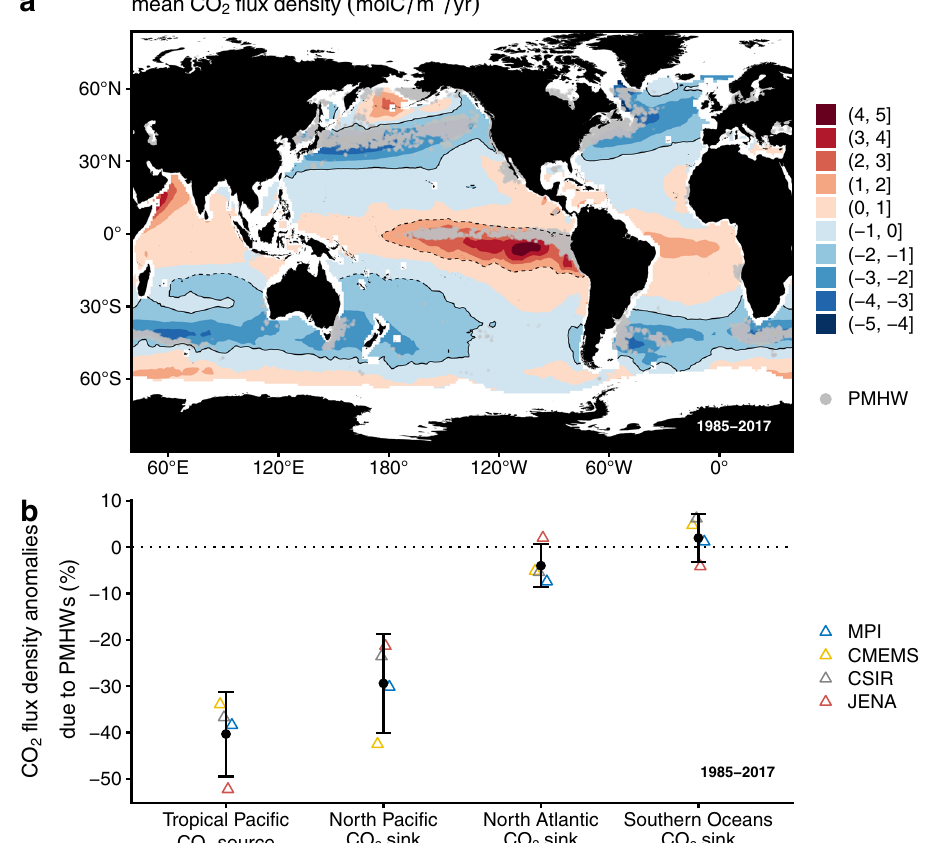
Fig. 1 | Interplay of PMHWs and oceanic carbon CO 2 source and sink areas. a Mean 1985 – 2017 air-to-sea CO 2 fl ux density (F CO2 ) derived from the Copernicus Marine Service (CMEMS) observation-based product (see methods section). Negative values indicate oceanic uptake (blue), while positive values indicate oceanicoutgassing (red)ofCO 2 . The black continuous/dashed contoursrepresent critical CO 2 sink/source regions, i.e the regions where the mean 1985 – 2017 F CO2 is lower/greater than − 1/1 molC/m 2 /yr as proposed by Takahashi et al. 35 . The gray points represent satellite Sea Surface Temperature grid points that have experi- encedatleast3PMHWsfrom1985to2017(seetextfordetails). b Trimmedaverage percent F CO2 anomalies during PMHWs derived from an ensemble of four observation-based products of F CO2 (see section methods) in critical oceanic CO 2